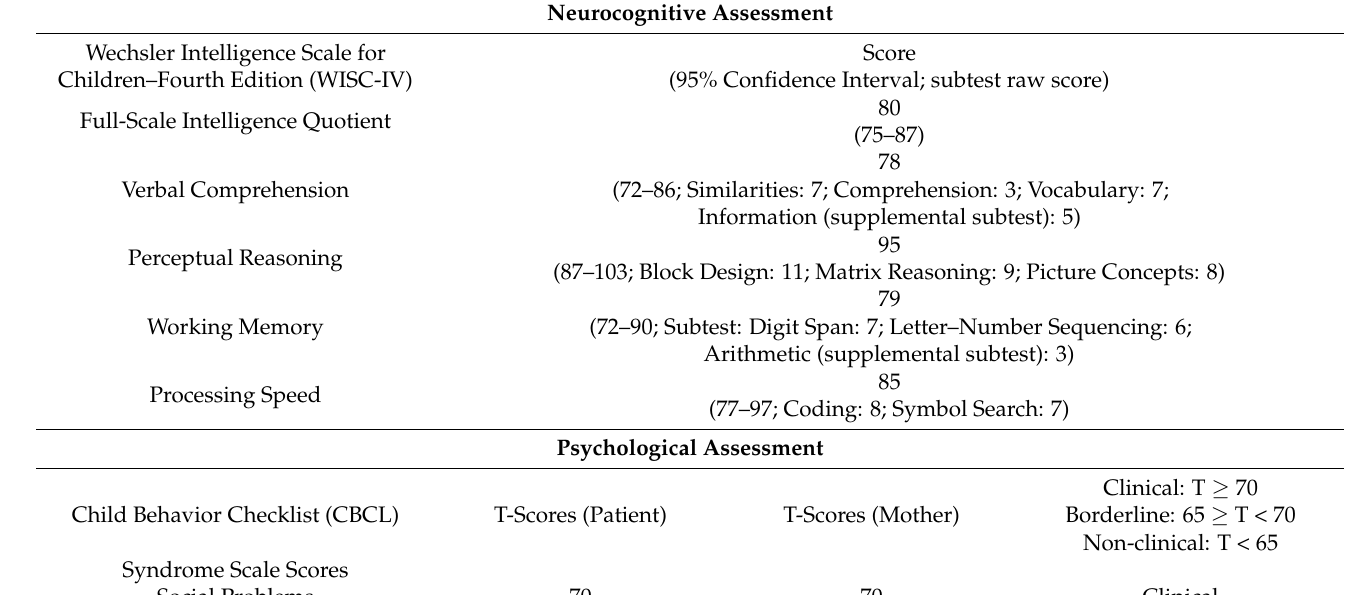
Table 2. Neurocognitive and psychological